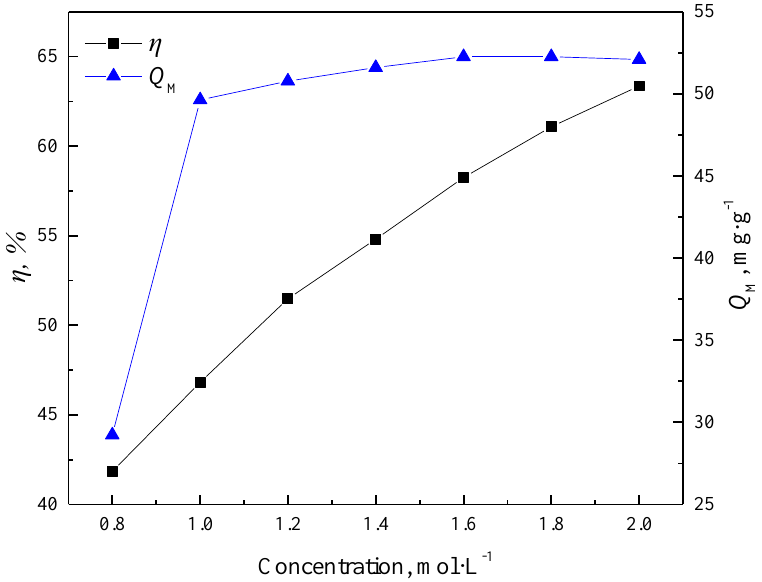
Figure 2. Effects of extractants concentration on the impregnation ratio of N-TIRs and adsorption capacity for V(V) (N235: TBP = 9:1).